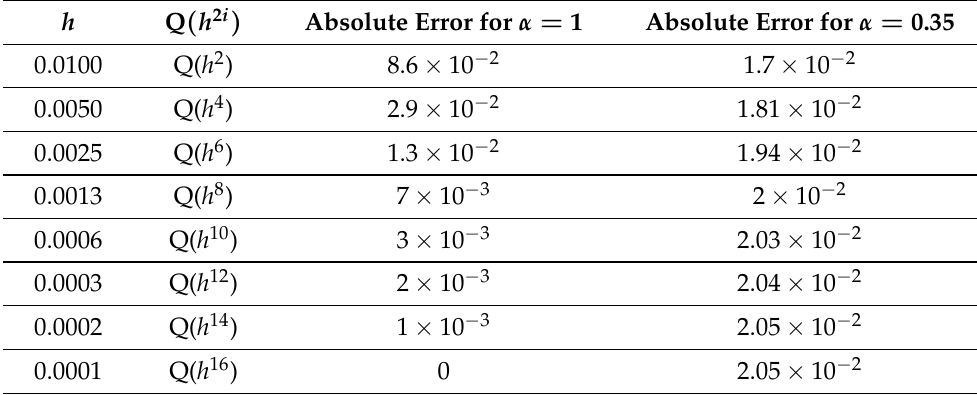
Table 10. The absolute error for Richardson extrapolation between α = 1 and α =